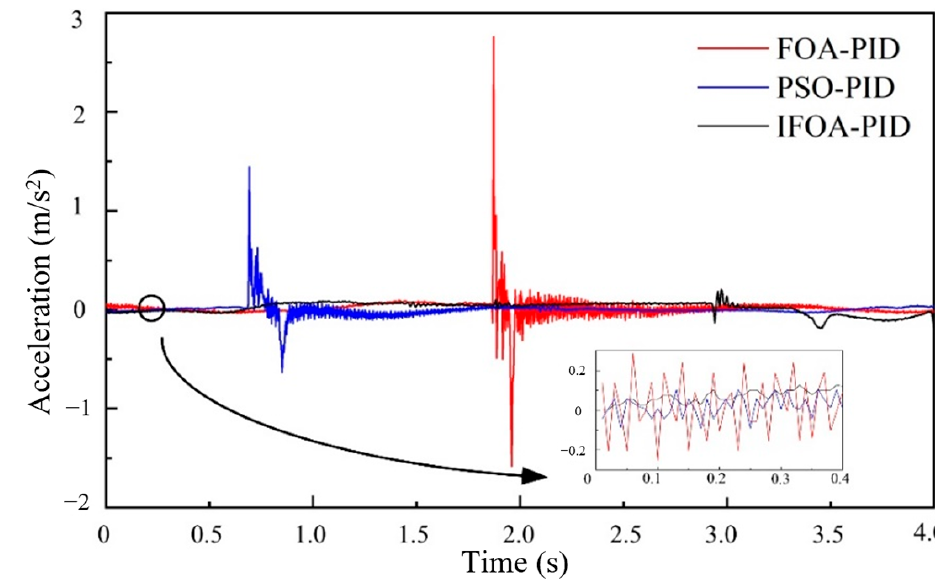
Figure 21. Acceleration of frame at high-frequency.